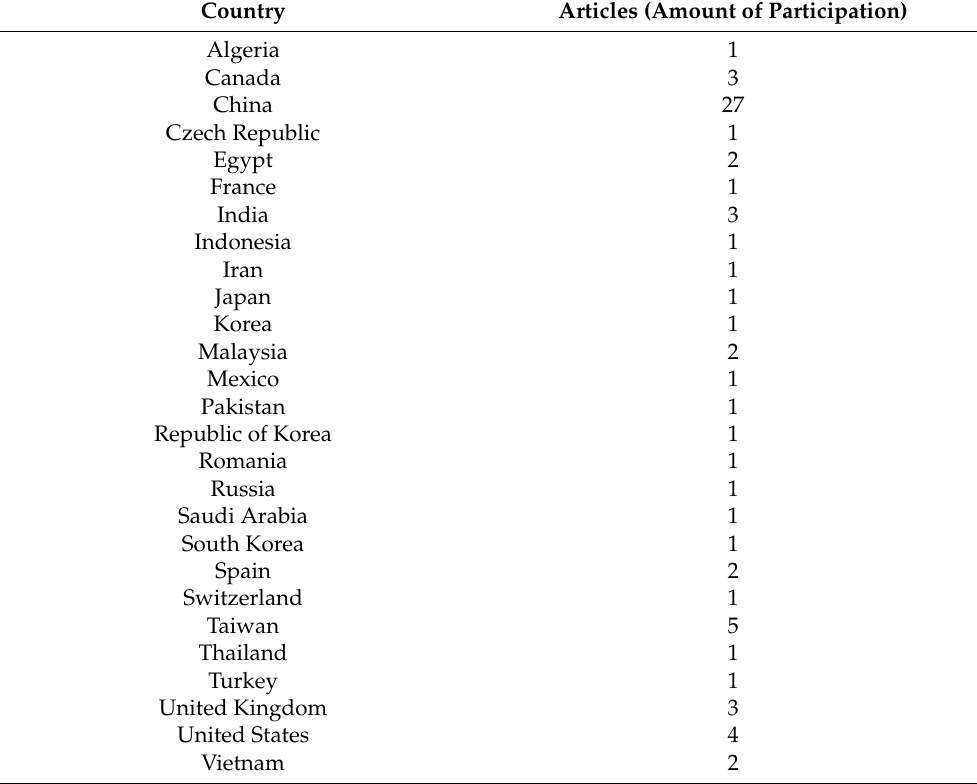
Table A1. Diversity of countries and articles referenced in this